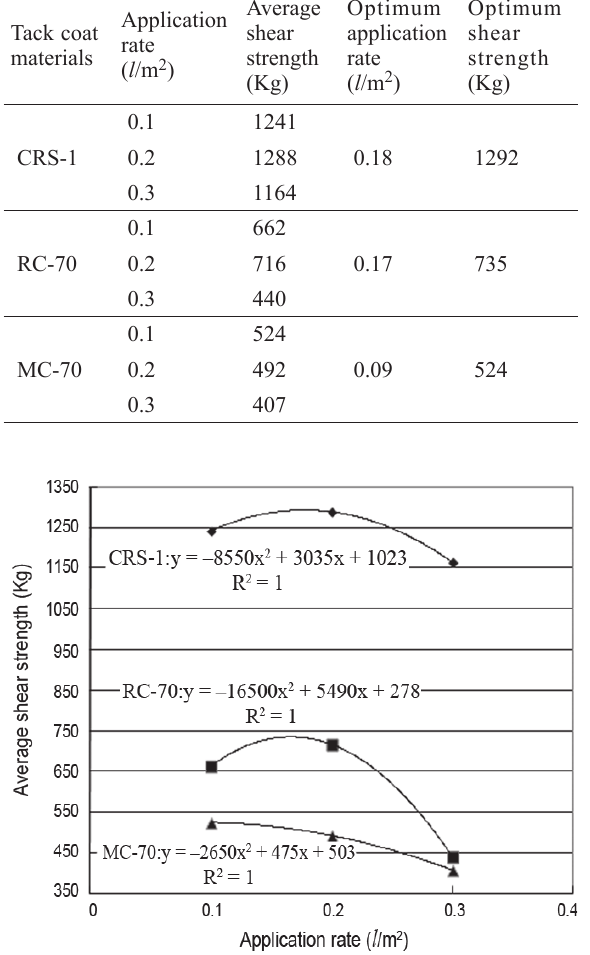
Fig. 3. Optimum application rate